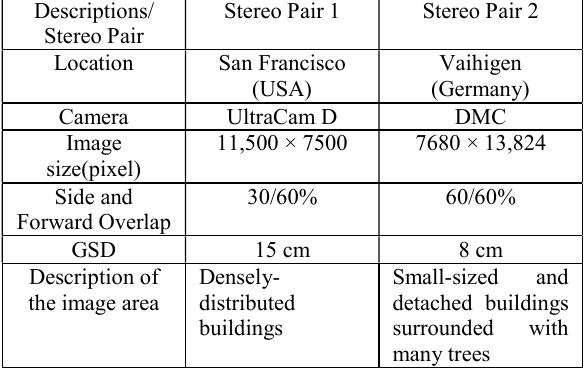
Table 1. Overview of the two pairs of frame images The first pair of line array images is cut from the nadir and backward strip of the airborne ADS40, which is a common line array camera. The pair of images is captured from suburban areas. The second pair of line array images is cut from a panchromatic image of GeoEye-1. Many low-rise buildings are present in the second pair of images.